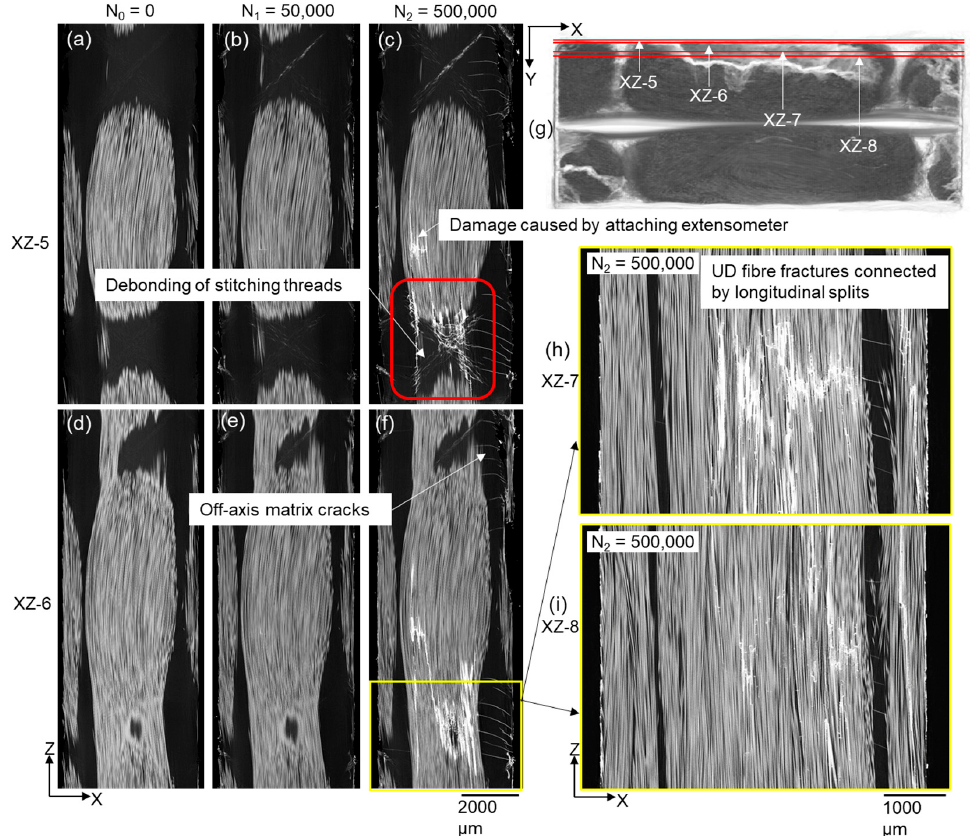
Figure 8. ( a – f ) and ( h , i ) Sub-surface X-ray CT virtual XZ sections showing the development of UD fibre fractures from the debonding of stitching threads. The Y-positions of the XZ slices are shown in ( g ).